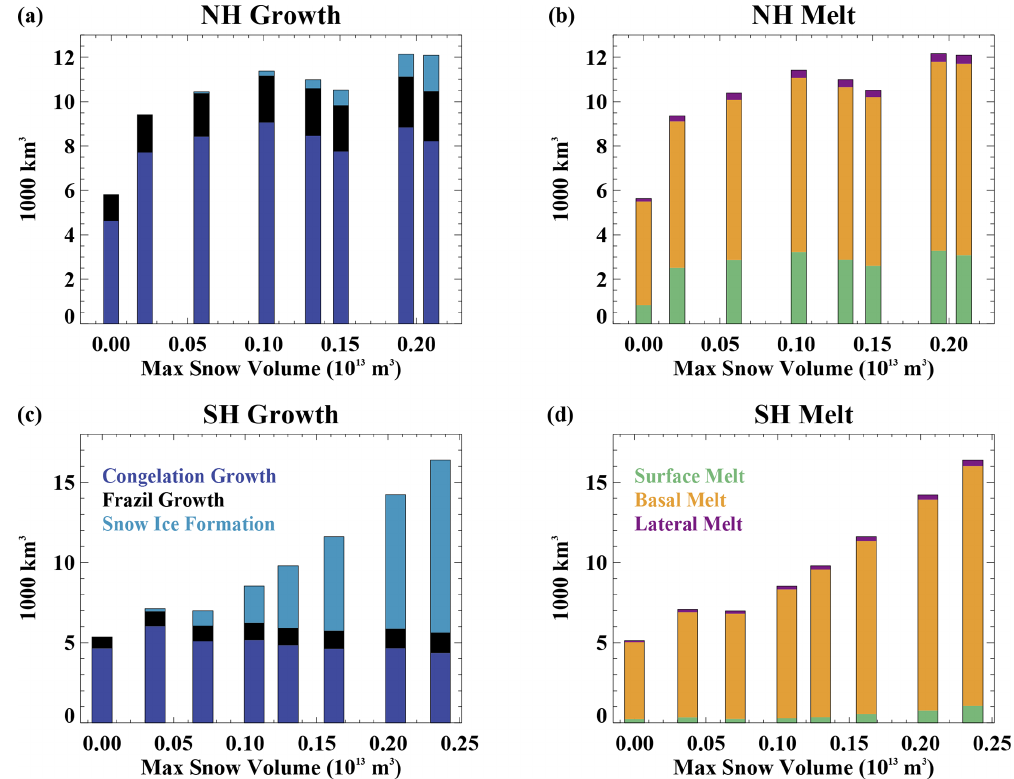
Figure 14. The volume in the 2xCO2 simulations of (a) Northern Hemisphere ice growth, (b) Northern Hemisphere ice melt, (c) Southern Hemisphere ice growth, and (d) Southern Hemisphere ice melt as a function of the maximum snow volume across the